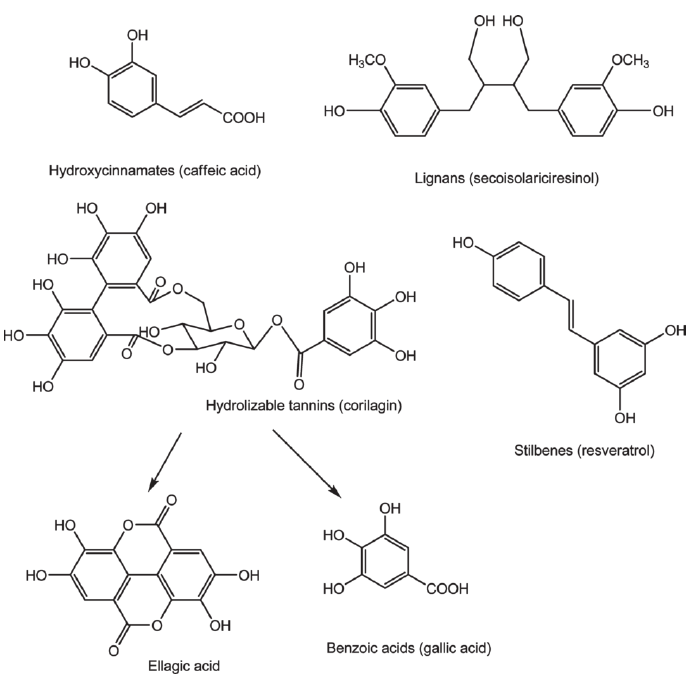
Figure 2. Nonflavonoid-type phenolics that are metabolized by the gut microbiota